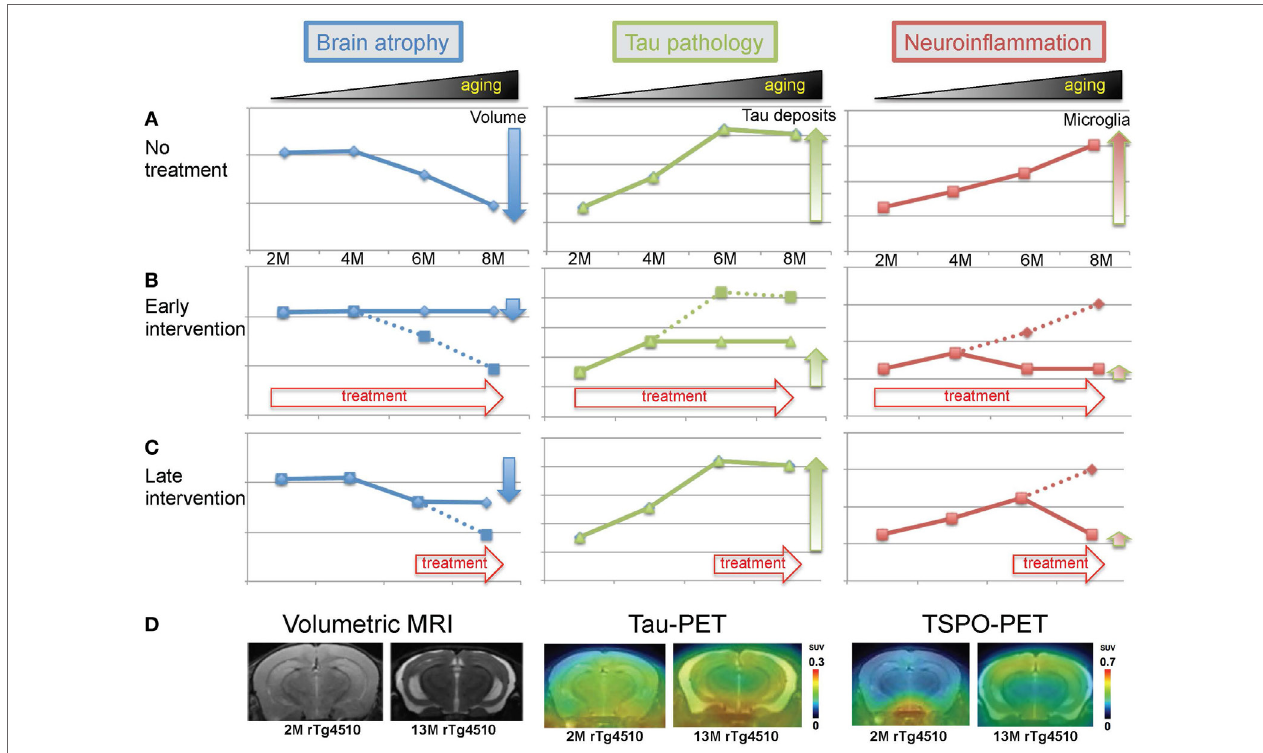
FiGURe 1 | Imaging modalities for investigating tau-induced brain atrophy and neuroinflammation. (A) Theoretical processes of volume change, pathological tau accumulation, and microglial activation in rTg4510 mice. (b) Effects of early intervention. Treatment was started from 2 months of age. (C) Effects of late intervention. Treatment was started from 6 months of age. (D) Representative images of volumetric magnetic resonance imaging (MRI), tau-positron emission tomography (PET), and translocator protein-PET in 2- and 13-month-old rTg4510